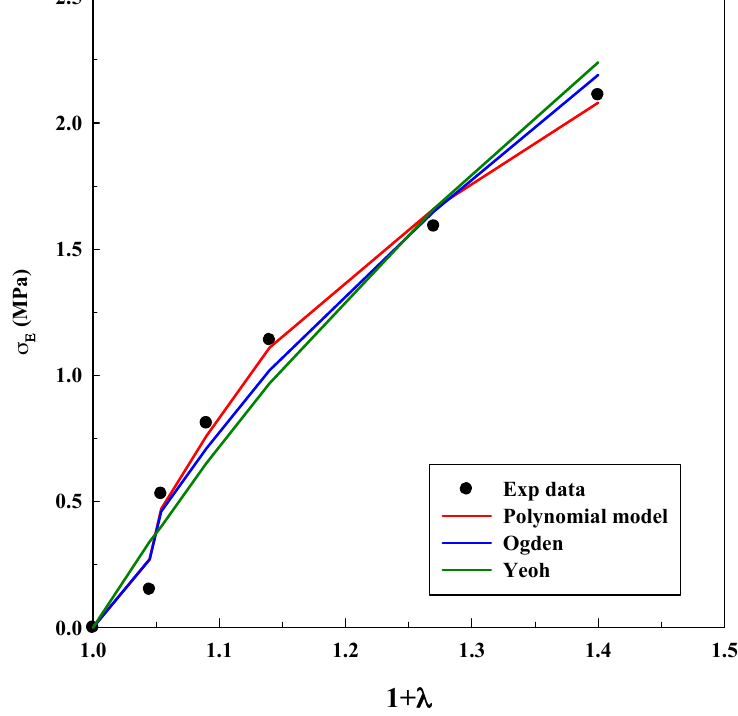
Figure 7. Models fitting of stress–elongation for the system A/G 80/20% v / v at 5% w / w .